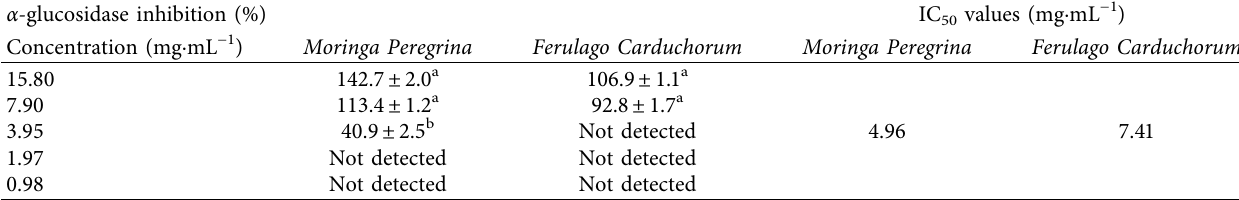
Table 1: α -Glucosidase enzyme inhibitory activity of Moringa peregrina and Ferulago carduchorum ethanolic extracts 1 . α -glucosidase inhibition (%)